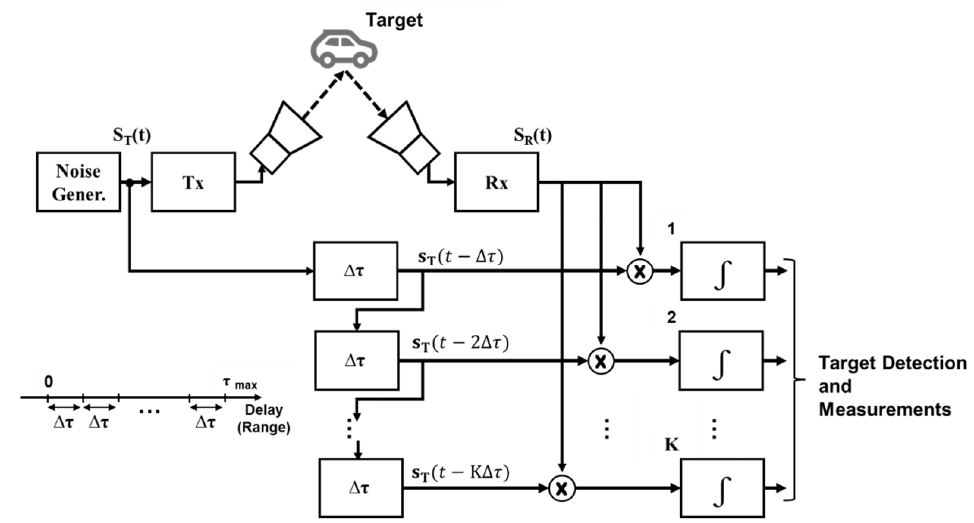
Figure 2. Configuration of the Noise Radar.